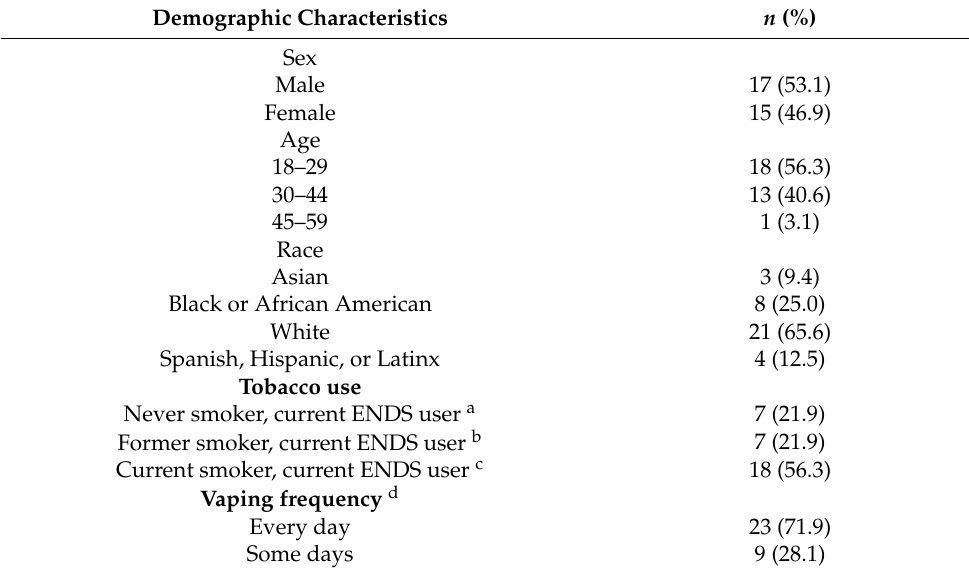
Table 1. Characteristics of focus group participants ( N =